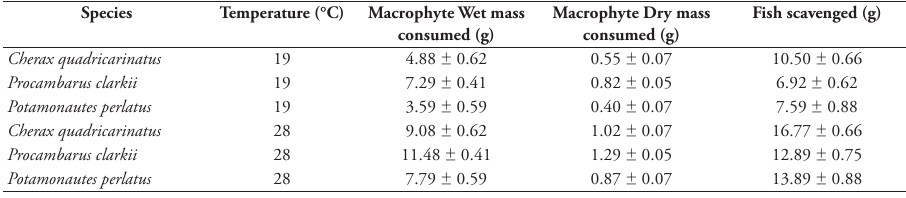
Table 3. Mean ( ± SE) consumption of macrophyte Potamogeton nodosus (in 24 hrs) and scavenging of fish Oreochromis mossambicus by Cherax quadricarinatus , Procambarus clarkii and Potamonautes perlatus at 19 °C and 28 °C.